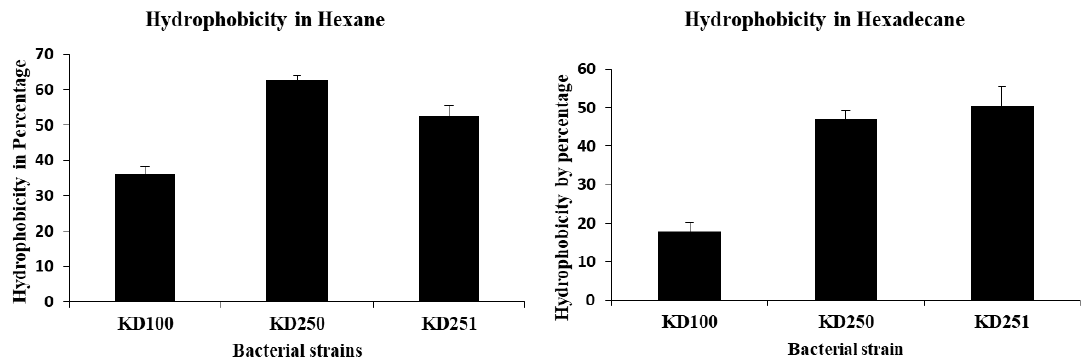
Figure 9. Cell surface hydrophobicity of P. carotovorum strains. Hydrophobicity was compared between mutants and parent. Bacterial suspensions in 0.5 × PBS (aqueous phase) were mixed with non-polar solvent hexane and hexadecane. The bars represent the percentages of bacteria remaining in the non-polar phase in contrast to aqueous phase. Values are the mean (from three replicates) ± standard deviation.